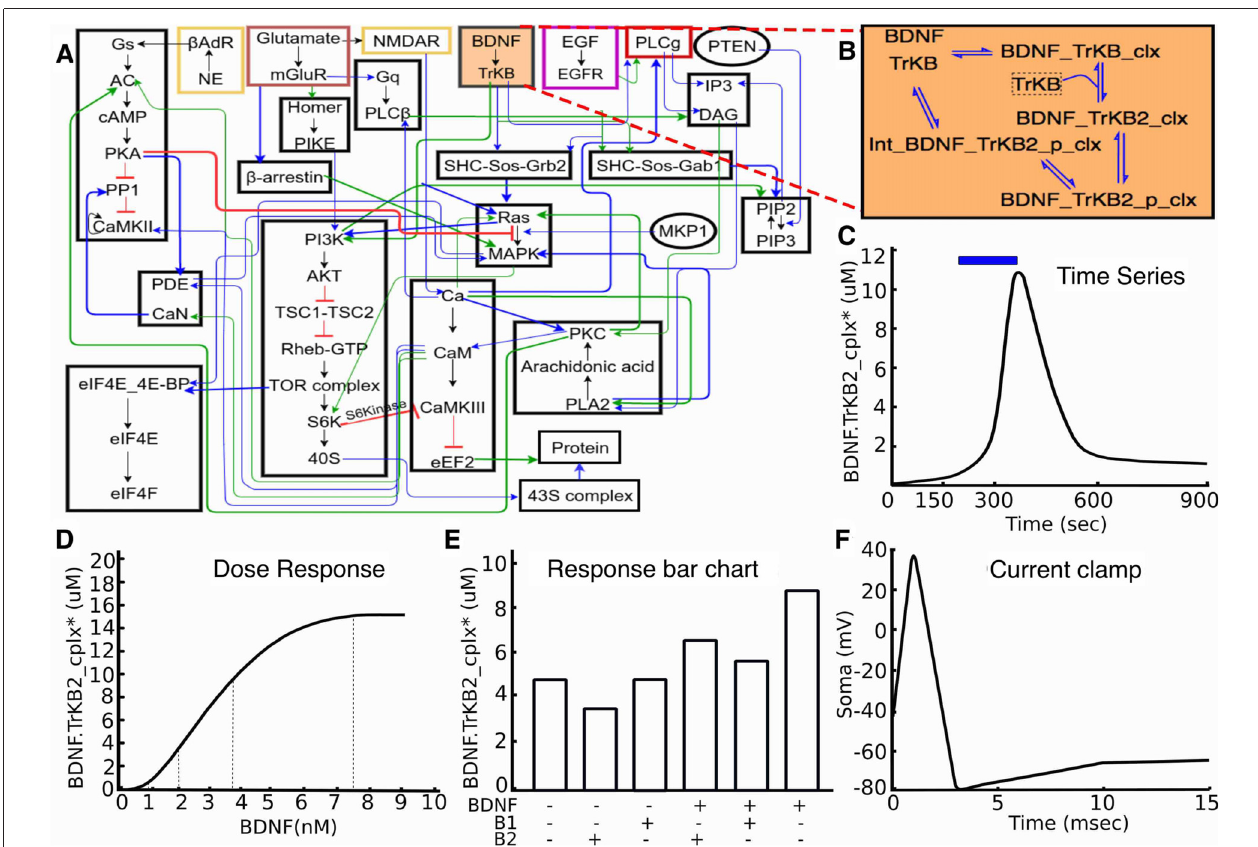
FIGURE 1 | Signaling model and experiments on it. (A) Block diagram of model. (B) Expanded reaction scheme for one of the reaction blocks. The experiments typically act on similar small subsets of the full model. (C–F) : Typical kinds of experiments on the model. (C) Time-series experiment with stimulus pulse (brain-derived neurotrophic factor (BDNF), blue) leading to signaling response (TrkB receptor activation, black). (D) Dose-response experiment, where defined BDNF stimuli lead to receptor activation. (E) Schematic of drug interaction experiment, where different combinations of stimuli are examined for their response, as shown by the bar chart. (F) Schematic voltage trace following a step current clamp